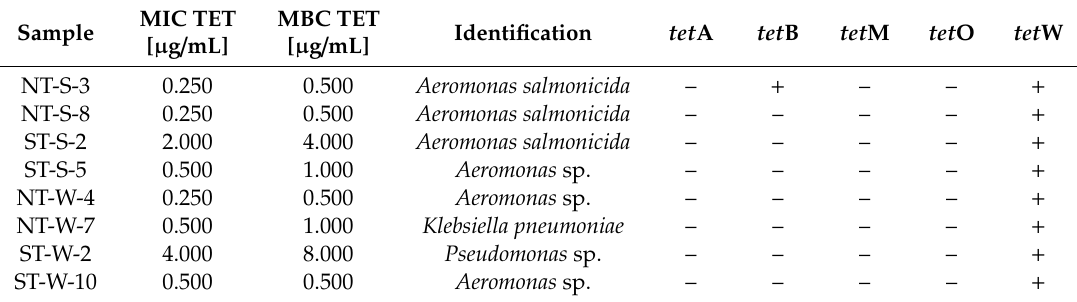
Table 3. Minimum inhibitory concentration (MIC), minimum bactericidal concentration